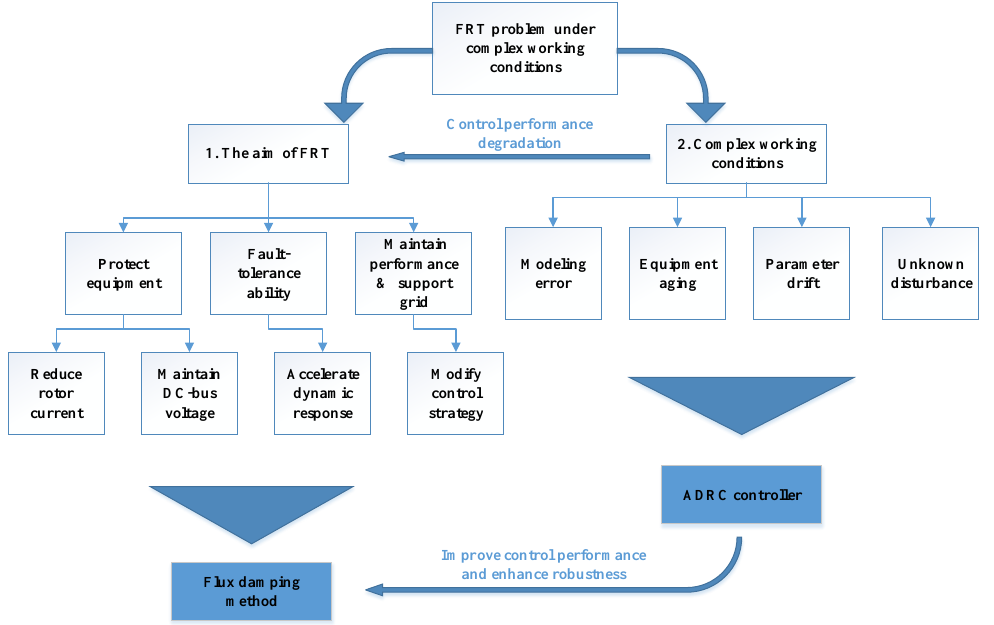
Figure 4. The flow chart of the integrated design of ADRC and flux damping method.